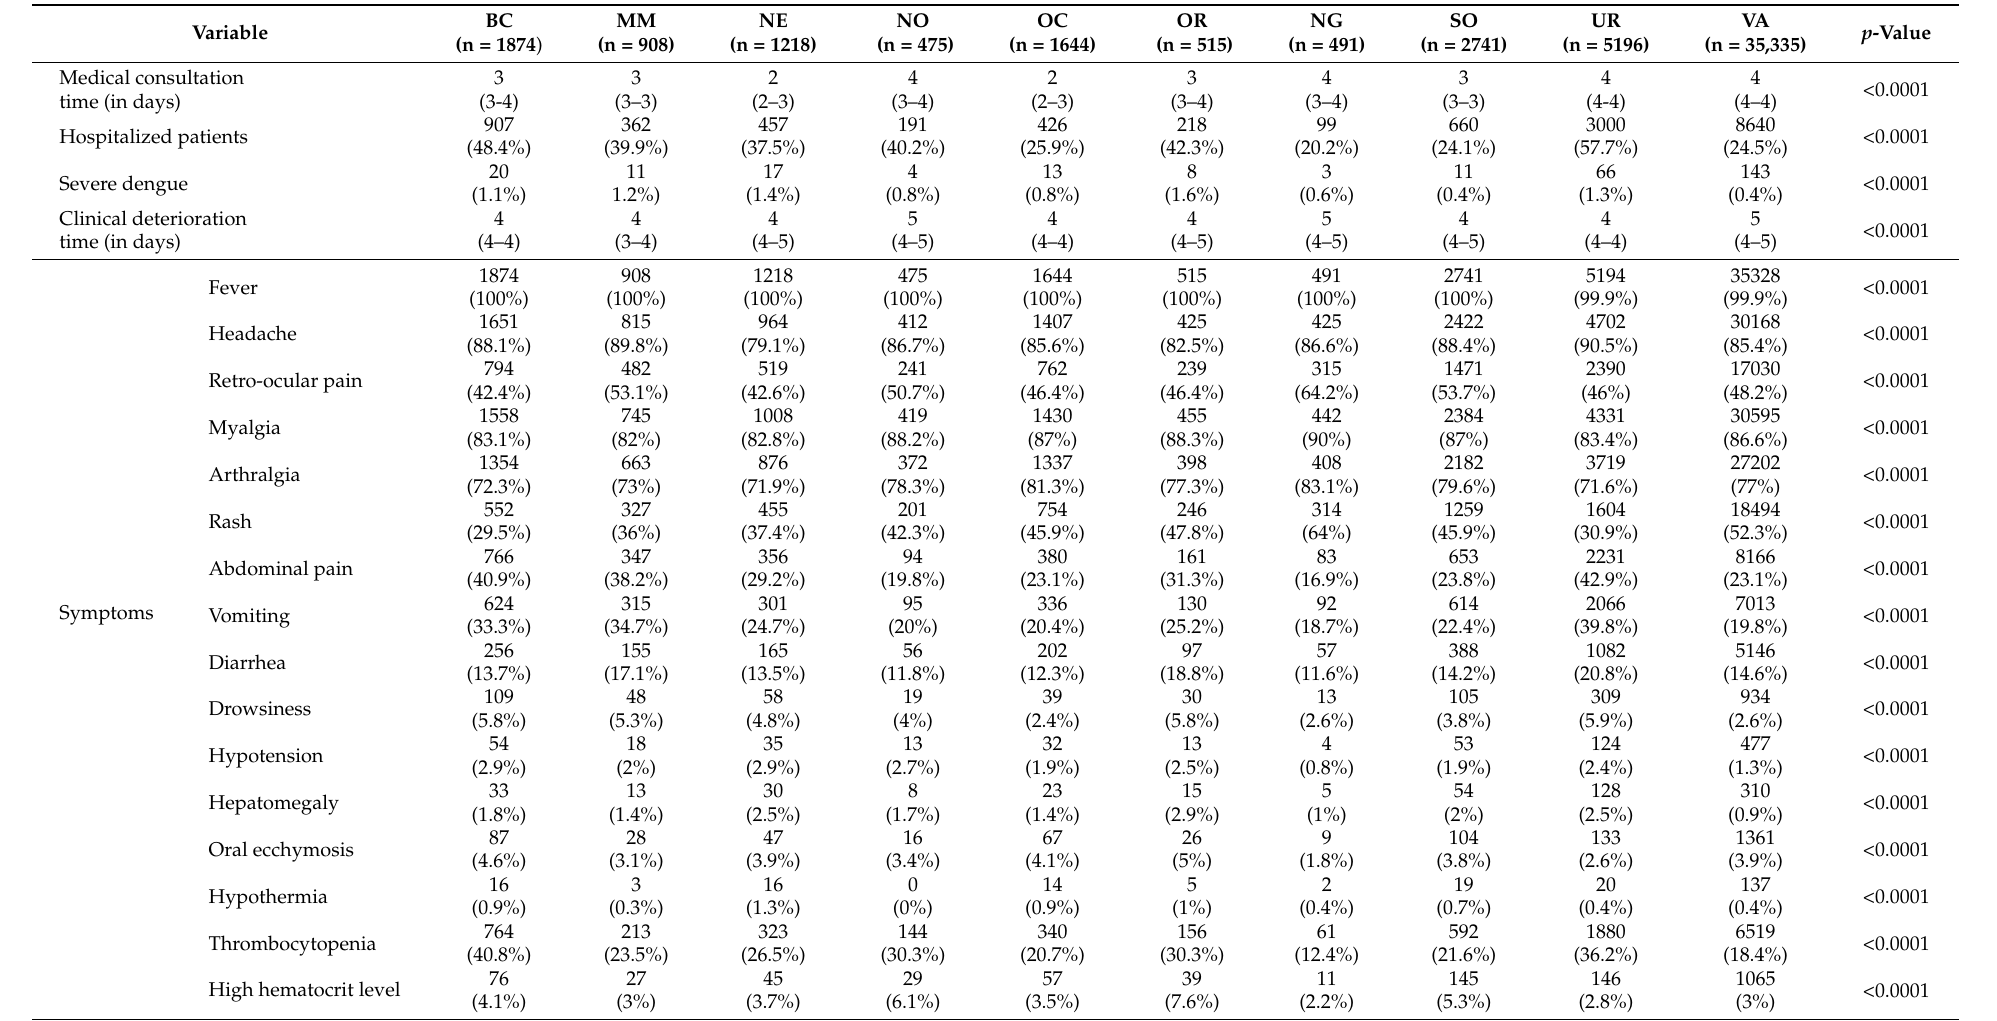
Table 6. Medical and symptomatically characteristics among patients, according to subregion